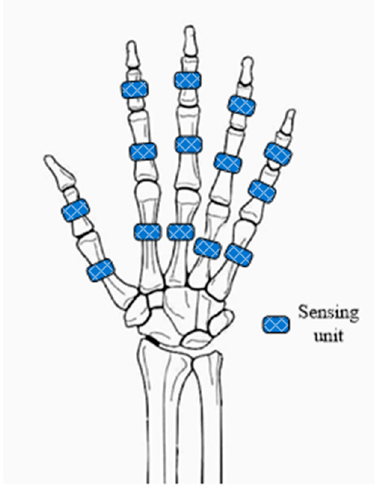
Figure 6. Distribution of sensing units on the back of a hand.